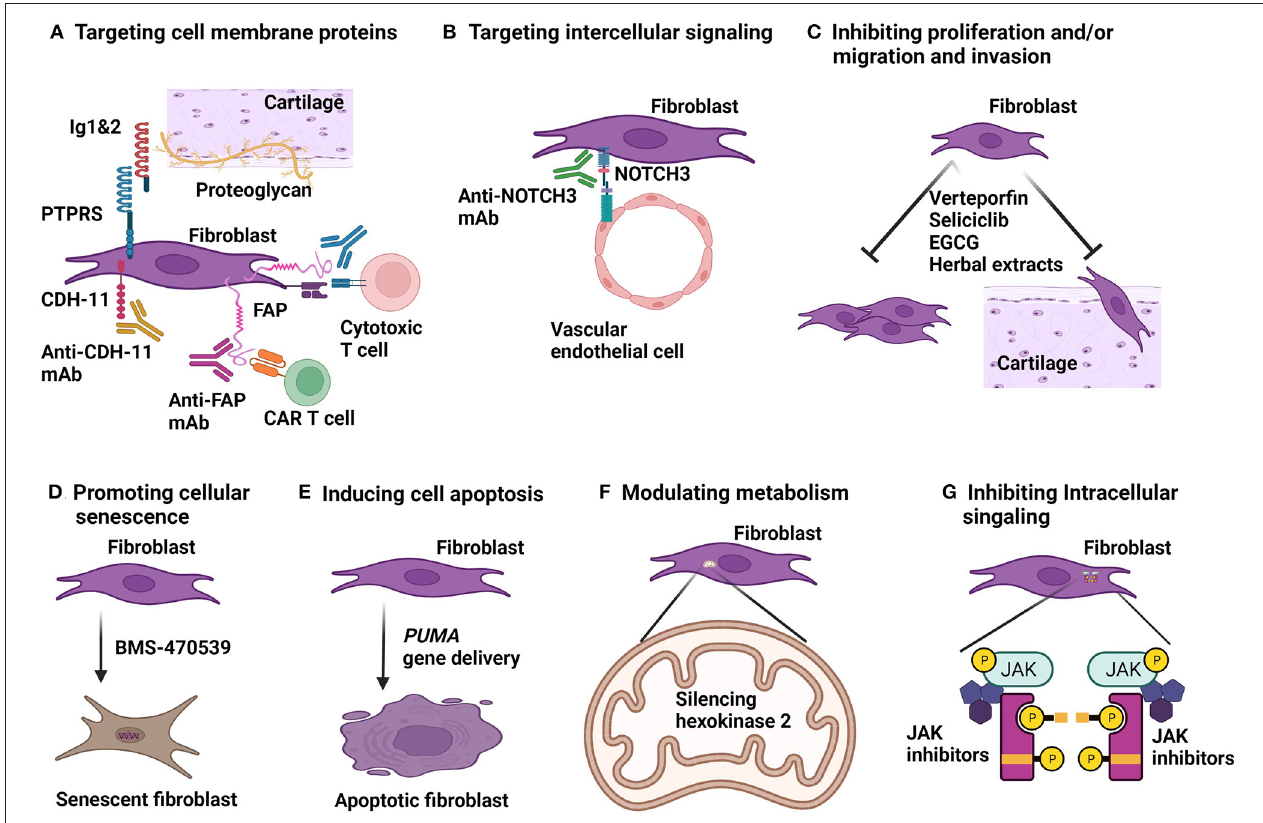
FIGURE 2 | Strategies for fibroblast targeted therapy. (A) Cell surface expressed proteins can be targeted in various ways. Therapeutic monoclonal antibodies (mAb) to cadherine-11 (CDH-11) and fibroblast activation protein (FAP) have been developed. FAP can also be targeted by chimeric antigen receptor (CAR) T cells and by vaccination which will provoke antibodies and cytotoxic T cells against FAP in vivo . Immunoglobulin like domain 1&2 (Ig1&2) acts as a decoy receptor blocks protein tyrosine phosphatase receptor type S (PTPRS) binding to proteoglycan. (B) mAb to neurogenic locus notch homolog protein 3 (NOTCH3) can block interaction between fibroblasts and endothelial cells. (C) Several approaches to inhibition of fibroblast proliferation and migration have been investigated. Transcriptional co-activators, Yes-associated protein (YAP) and transcriptional co-activator with PDZ-binding motif (TAZ) are active in RA fibroblasts. Verteporfin blocks YAP/TAZ binding to transcriptional enhanced associate domains (TEAD) and has anti-arthritic effect in arthritis models. Seliciclib blocking RA fibroblast proliferation and has been in a clinical trial for treating RA. Green tea extract, epigallocatechin-3-gallate (EGCG) and several Chinese herbal extracts are shown to inhibit RA synovial fibroblast proliferation, migration and invasion in vitro and anti-arthritic effect in animal models of arthritis. (D) Activation of a G-protein coupled receptor, melanocortin type 1 receptor (MC1R) by a selective agonist, BMS-470539 can induce senescence and diminish activity of RA fibroblasts. (E) Delivery of pro-apoptotic gene, PUMA (p53 upregulated modulator of apoptosis) induced RA synovial fibroblast cell death and has anti-arthritic effect in arthritis models. (F) Glucose metabolism of RA synovial fibroblasts are high active. Silencing hexokinase 2, a glycolytic enzyme resulted in reduction of migration and invasion of RA fibroblasts in vitro . (G) Janus kinase (JAK)-signal transducer and activator of transcription (STAT) pathway is active in RA synovial fibroblasts. Fibroblast-selective JAK inhibitors are required to inhibit JAK-STAT mediated cytokine signaling for RA synovial